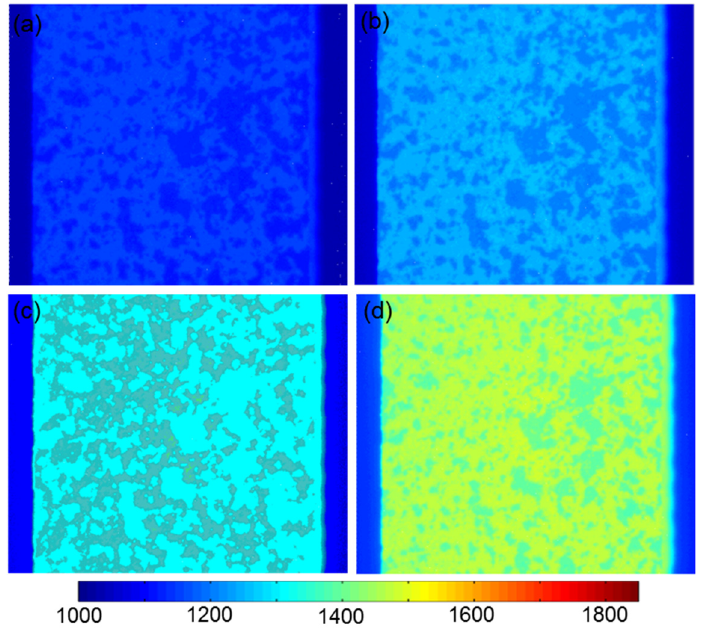
Figure 9. Typical temperature fields at ( a ) 1173 K, ( b ) 1273 K, ( c ) 1373 K and ( d ) 1473 K.